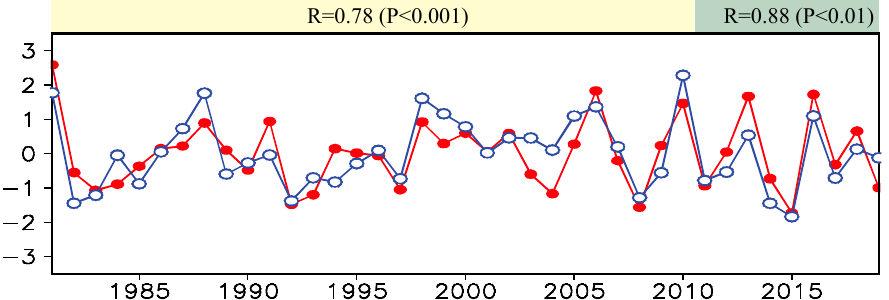
Figure 11. Normalized time series of the summer observational (red line) and simulated/predicted (blue line) eastern TP SAT indices. The correlation coefficient is 0.78 and 0.88 for the training period 1981–2010 and the prediction period 2011–2019, respectively.